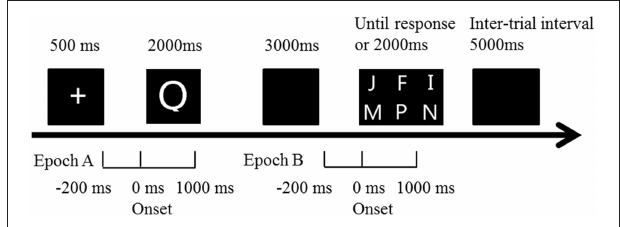
FIGURE 1 | Illustration of the trial time course in the DMS paradigm. Subjects were presented with one single letter (sample stimulus). They had